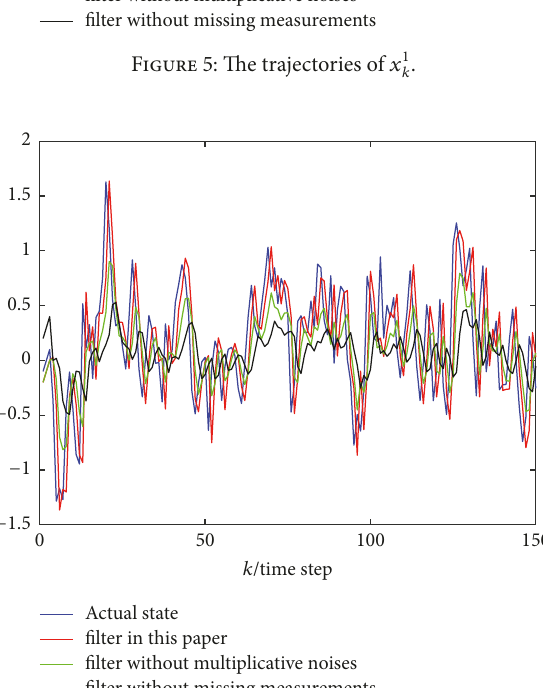
Figure 7: log ( MSE 1) .